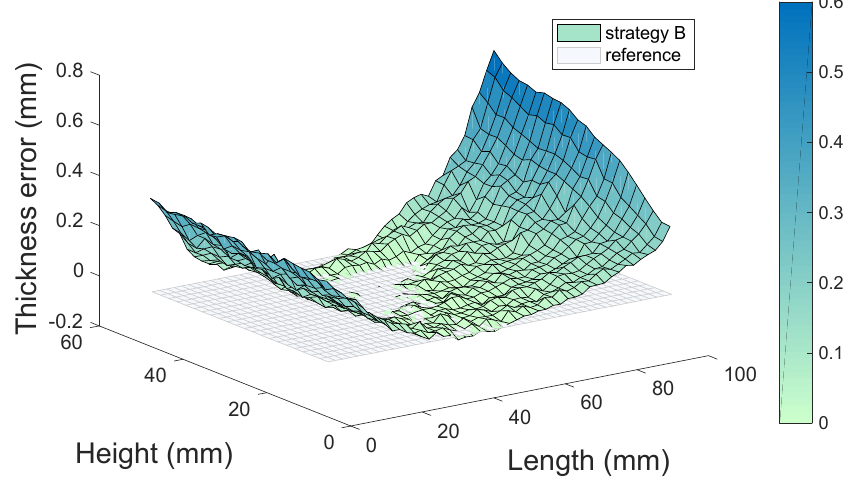
Figure 16. Airfoil thickness for strategy B.